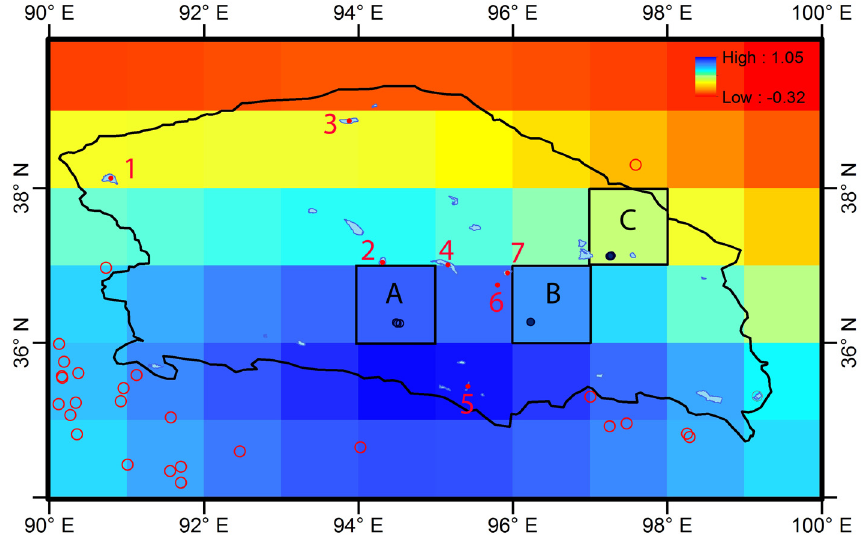
Fig 2. Changes in TWS from 2003 to 2012 in the QB and the locations of lakes. Lakes inside the QB with water level data are numbered as shown in Table 1 and those around the QB are marked in red circles. Three grids with observation wells (represented by black circles) are marked as A, B, and